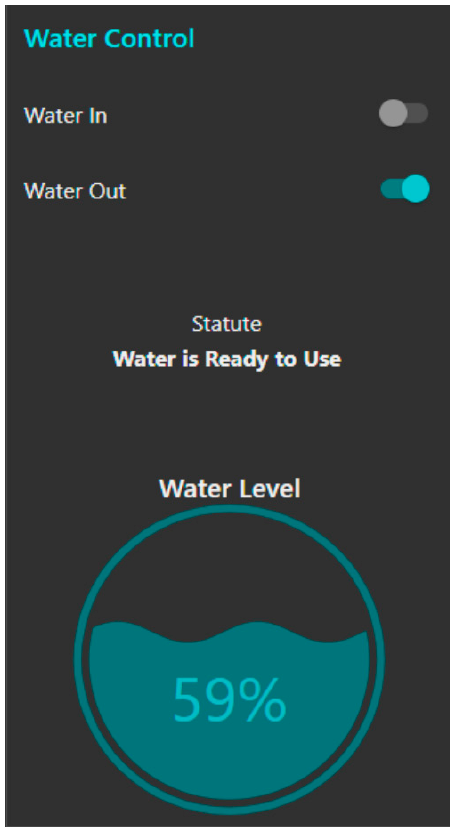
Figure 9. Smart mobile app dashboard to monitor and control water level remotely.